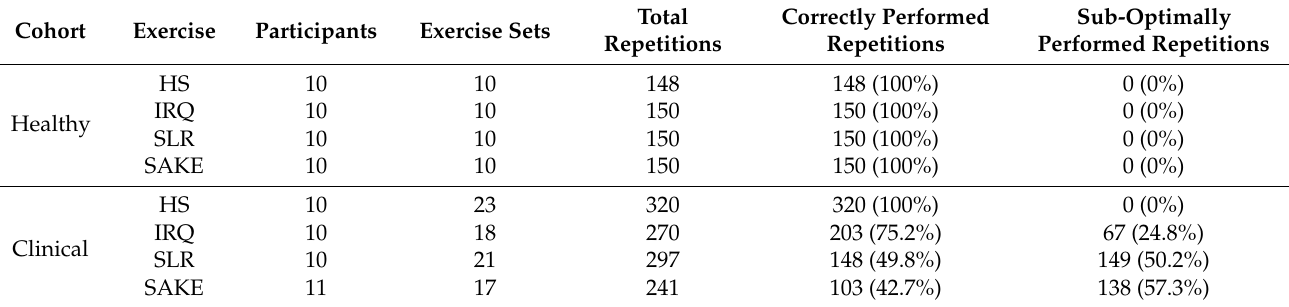
Table 4. Data collected to form the test